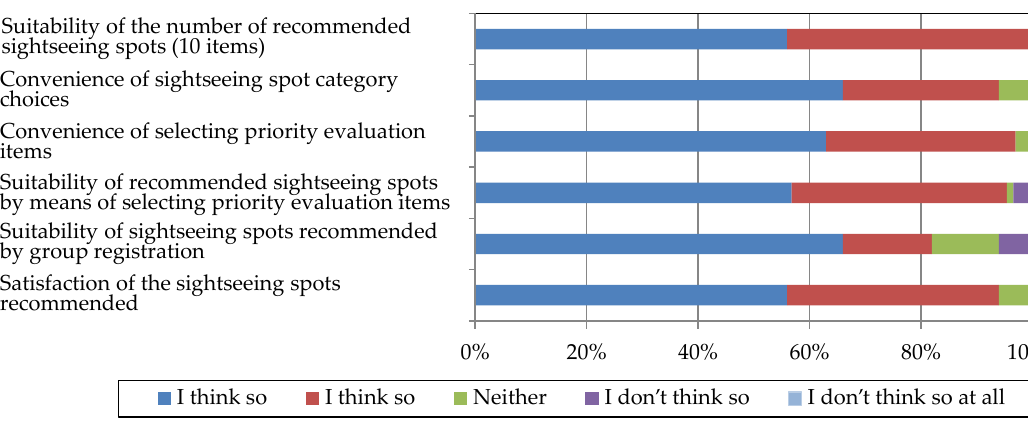
Figure 10. Detailed evaluation concerning the recommendation function of sightseeing spots.